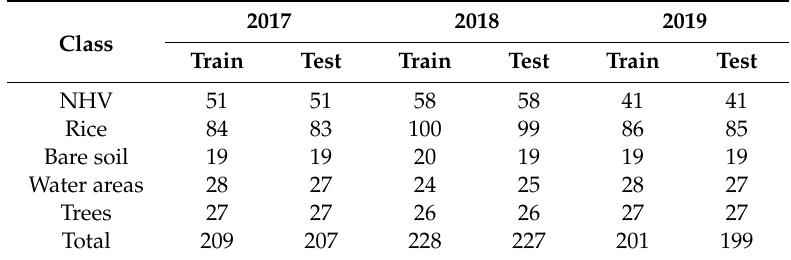
Figure 2. Ground samples collected for the 2019 rice growing season. Table 1. Yearly number of Random Forest (RF) training and test samples for each land cover (LC) class. NHV—natural herbaceous